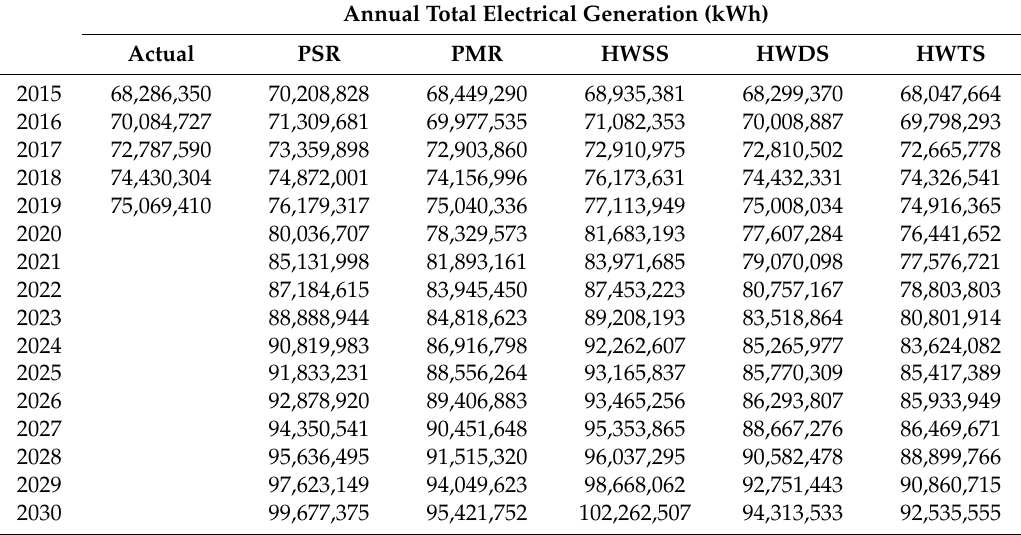
Table A1. The real data and the forecasted annual generation of electricity for Kuwait from 2015–2030.